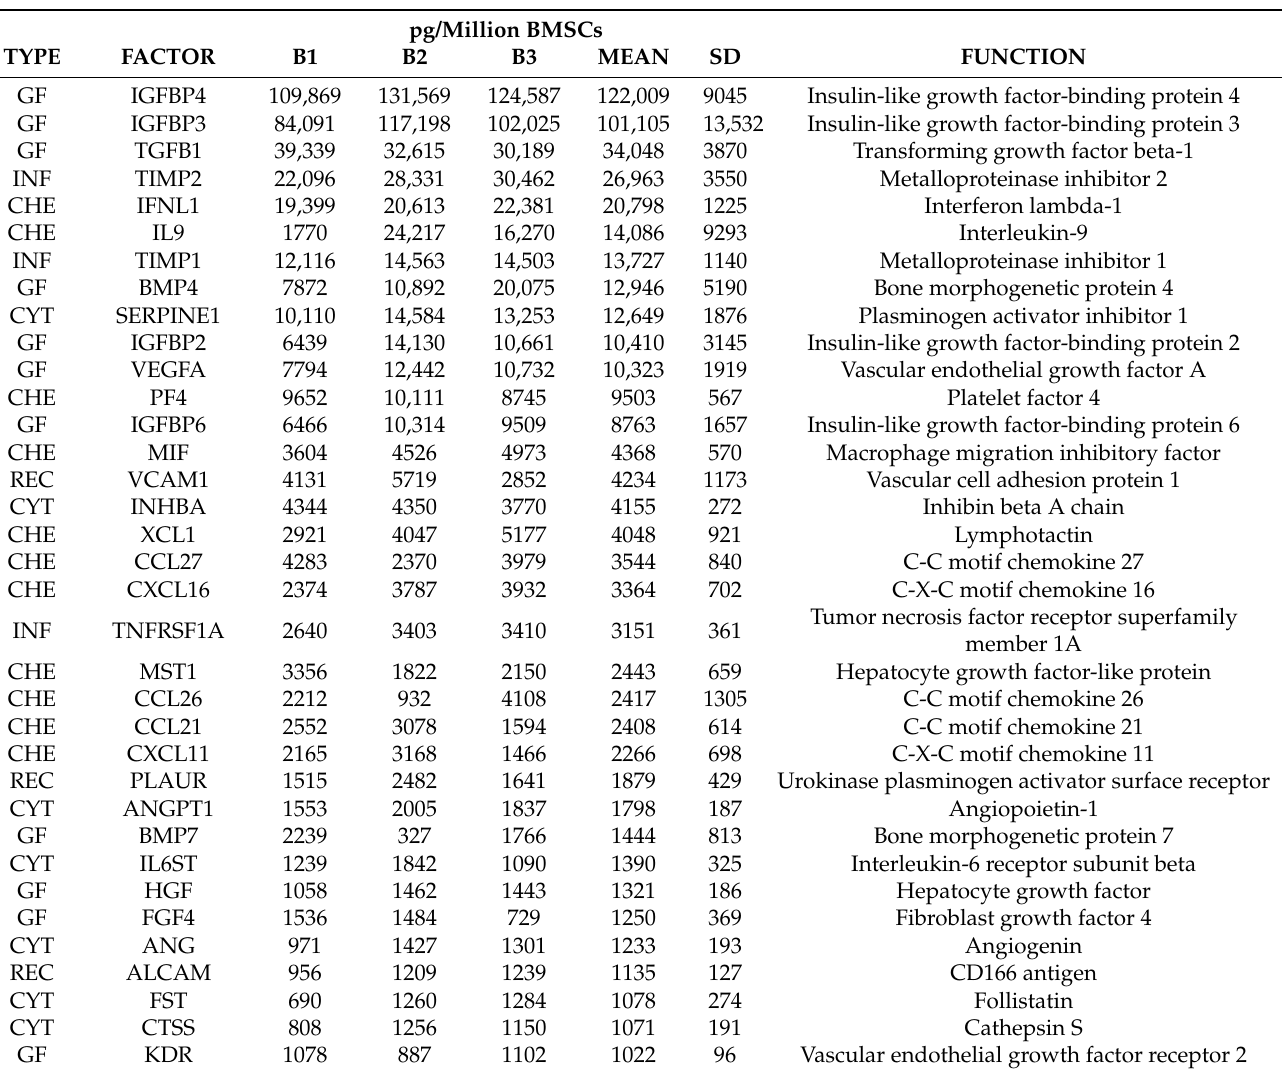
Table 2. Most abundant (>1000 pg/million cells) SF-treated BMSCs